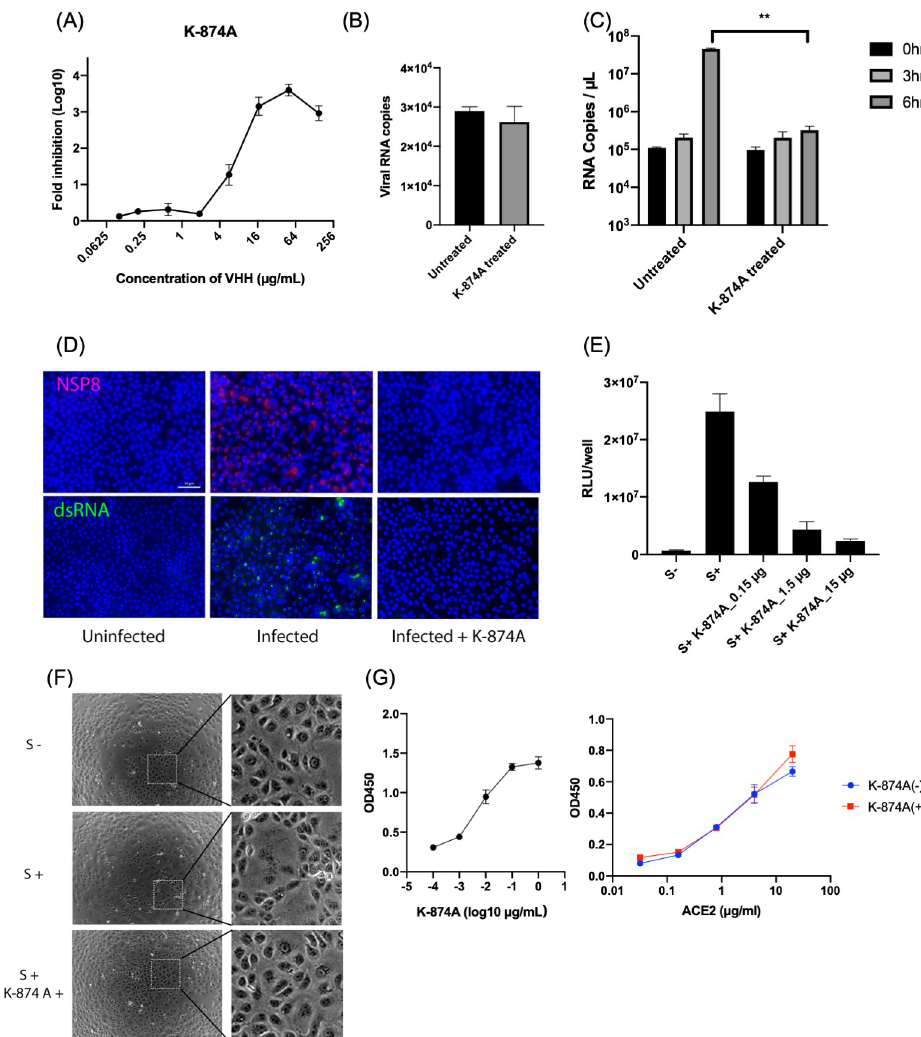
Fig 2. K-874A VHH neutralizes SARS-CoV-2 by preventing viral fusion with host cell. ( A ) Neutralization of SARS-CoV-2 by K-874A VHH. SARS-CoV-2 was pretreated with different concentrations of K-874A and inoculated into VeroE6/TRMPSS2 cells. Fold-reductions in viral RNA copies in culture supernatants were calculated by qRT-PCR. K-874A has an IC 50 of 5.74 ± 2.6 μ g/ml. Error bars indicate mean ± SD from three independent experiments. ( B ) The numbers of viral RNA copies in VeroE6/TMRPSS2 cells infected with SARS-CoV-2 (untreated) and SARS-CoV-2 pretreated with K-874A VHH (K-874A-treated) were similar. Number of RNA copies attached or incorporated in the cells were determined by qRT-PCR. Error bars indicate mean ± SD from three independent experiments. ( C ) Number of viral RNA copies in VeroE6/TMRPSS2 cells infected with untreated SARS-CoV-2 and K- 874A-treated SARS-CoV-2 at 0, 3 and 6 hr. RNA levels were estimated by qRT-PCR (N = 3, �� P < 0.005, Welch’s t test). ( D ) Immunofluorescence images show viral protein, NSP8, and RNA replication are suppressed in Vero/TMPRSS2 cells infected with K-874A-treated SARS-CoV-2. SARS-CoV-2-infected cells were fixed at 24 hr after infection and treated with anti-NSP8 (red) or anti-dsRNA (green). After fluorescence-conjugated secondary antibody and Hoechest (blue) treatment, images were captured by BZX800. Scale bar = 50 μ m. ( E ) Cell fusion induced by S protein transduction in HiBiT- and LgBiT-expressing VeroE6/TMPRSS2 cells. Treatment with K-874A VHH suppressed cell fusion in a dose-dependent manner. Error bars indicate mean ± SD from three independent experiments. ( F ) Optical images of VeroE6/TMPRSS2 cells expressing S protein transduced by a lentivirus vector show cell fusion (S+) and no cell fusion when treated with K-874A VHH (S+K-874A+). Inset: magnified view of dotted square shown in left panels. ( G ) ELISA results show K-874A (left) and ACE2 (right) bound to immobilized recombinant S protein in a dose- dependent manner. Immobilized S protein was detected by serially diluted K-874A (1 to 0.002 μ g/well) and horseradish peroxidase (HRP)-conjugated anti-VHH antibody (left), or by serially diluted ACE2 protein (20 to 0.0625 μ g/ml) and anti-ACE2 antibody and HRP-conjugated secondary antibody (right). Binding of ACE2 to S protein was unaffected by K-874A (1 μ g/well) treatment.